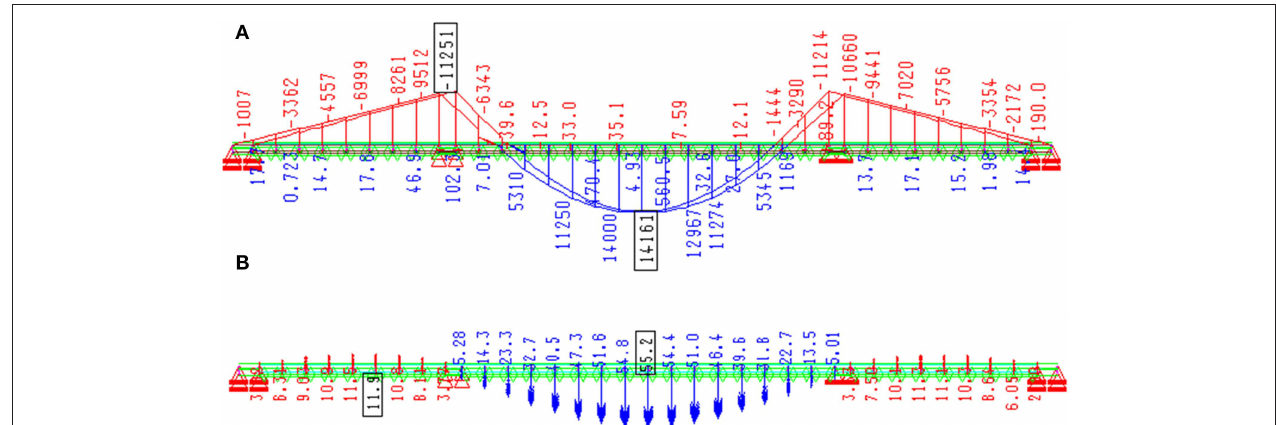
FIGURE 8 | Calculated values—phase 11; (A) bending moment; (B) vertical displacement.